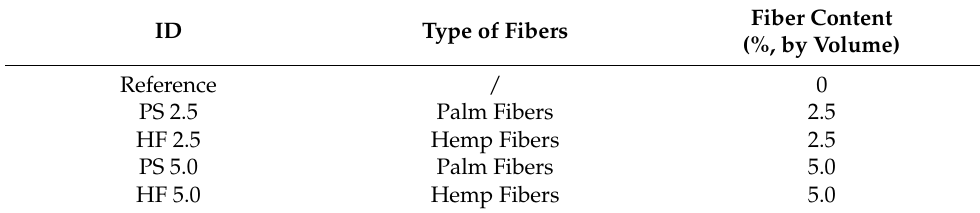
Table 1. Identification of the investigated